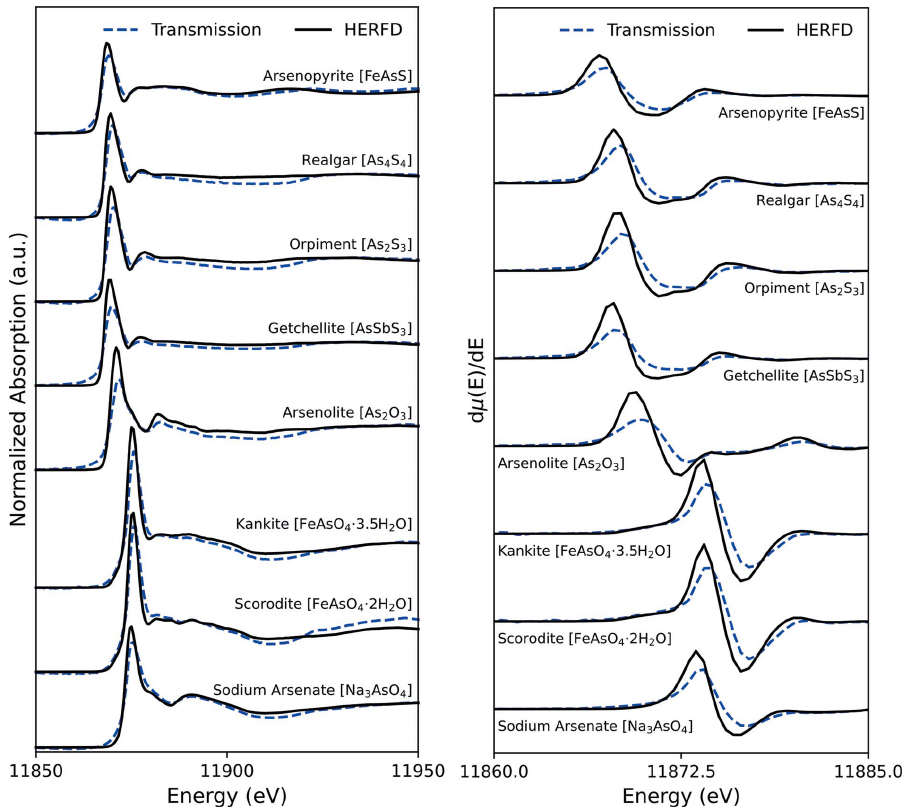
Figure 1 A comparison of normalized As K -edge XANES spectra collected in HERFD and transmission-detection modes for arsenic compounds associated with mine waste (left panel) and the first derivatives (right